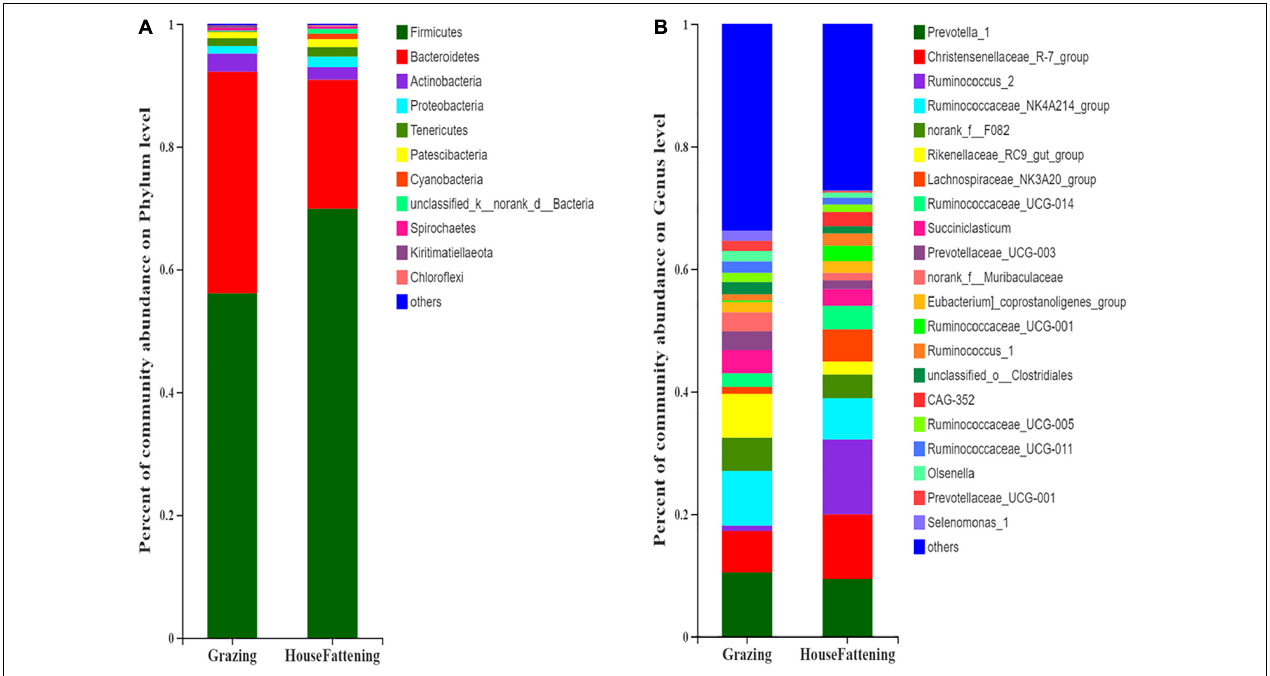
FIGURE 2 | Bacterial community compositions across the two feeding systems. (A) Phylum level; (B) Genus level.